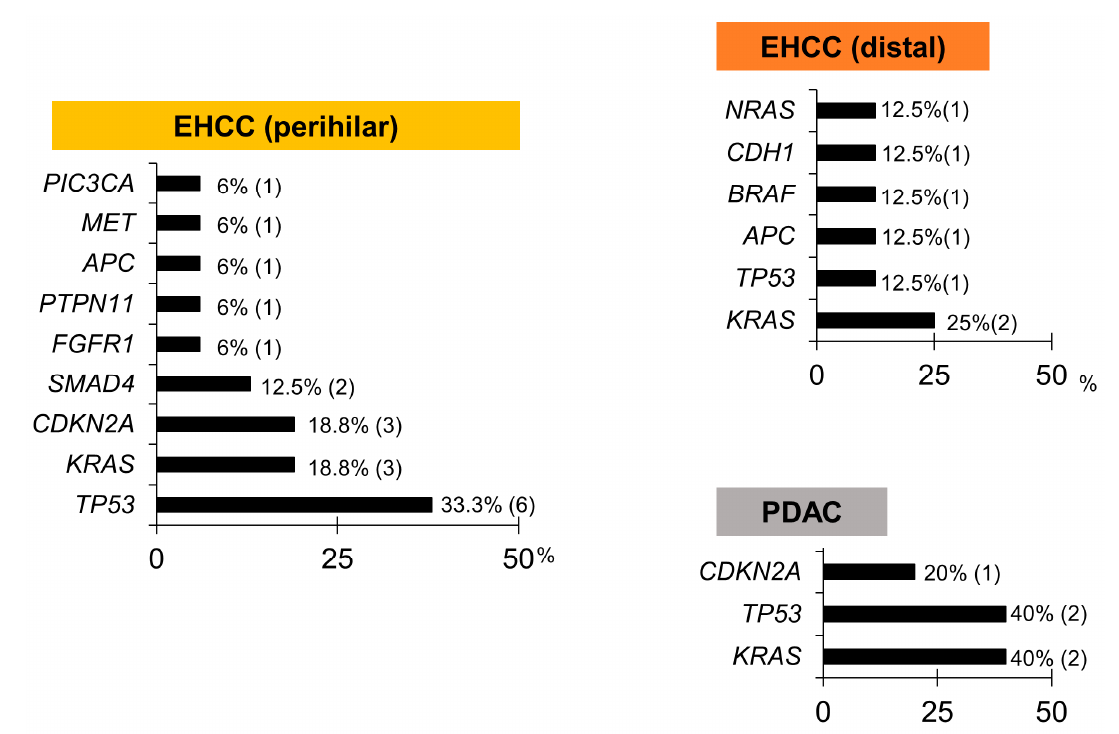
Figure 6. Pathogenic gene alteration frequencies in bile cfDNA, according to the cancer site. KRAS and TP53 mutations were the most frequent, followed by CDKN2A .